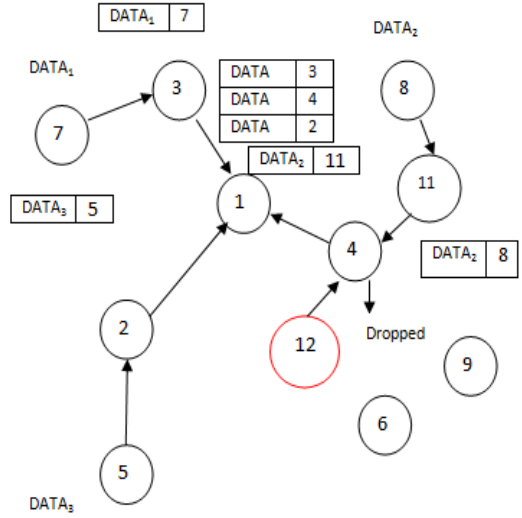
Figure. 6 packet drop scenario by syn flooding attacks